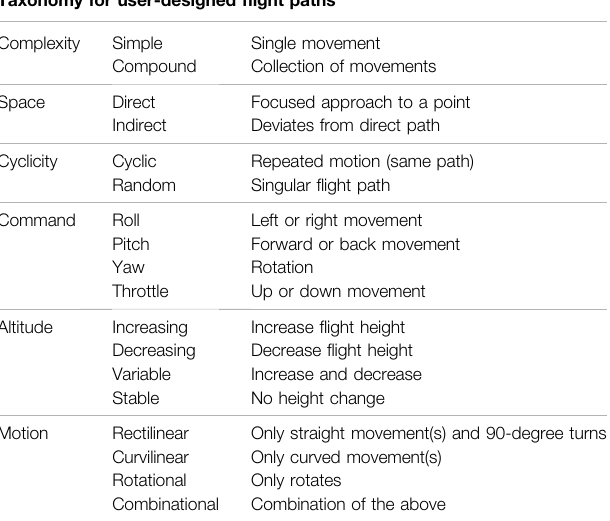
TABLE 1 | Taxonomy for UAV fl ight classi fi